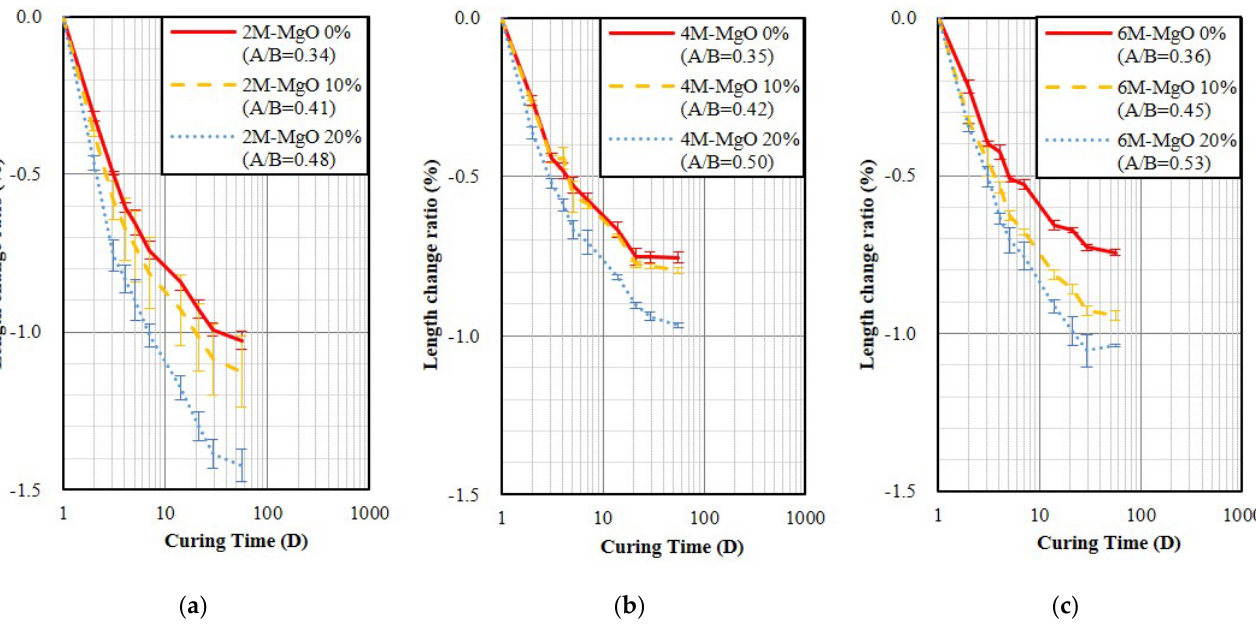
Figure 6. The length change ratios of the GP specimens fixed fluidity and demold at age of 24 h and then air-dry curing. ( a ) 2 M; ( b ) 4 M; ( c ) 6 M.